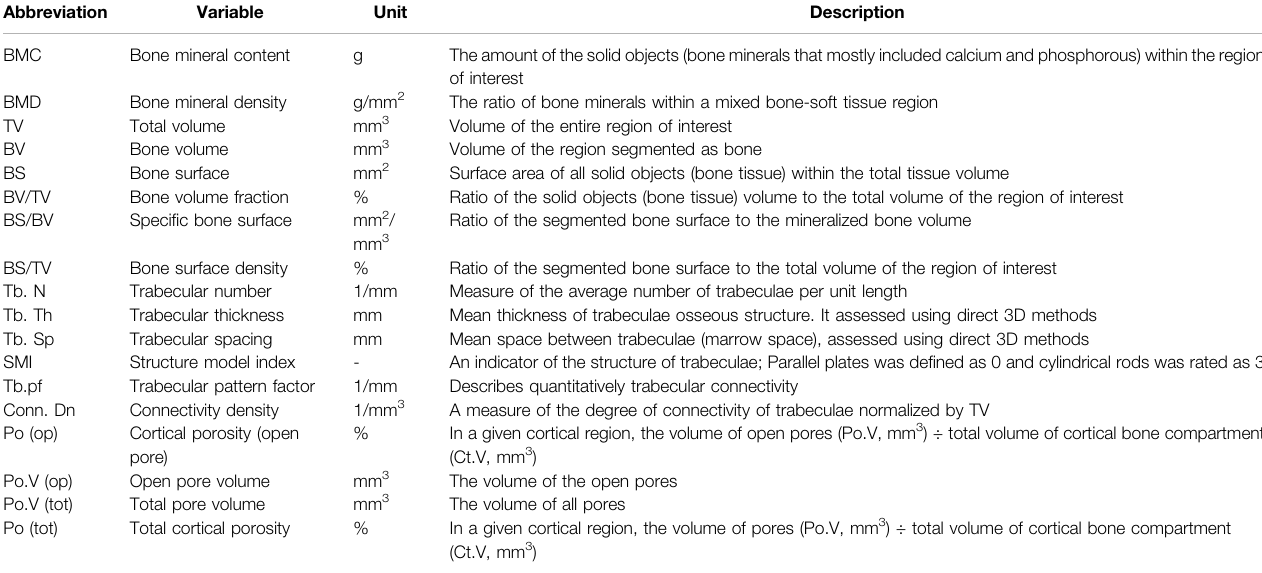
TABLE 2 | De fi nition and description of bone microstructure by using micro-CT method (Bouxsein et al., 2010). Abbreviation Variable